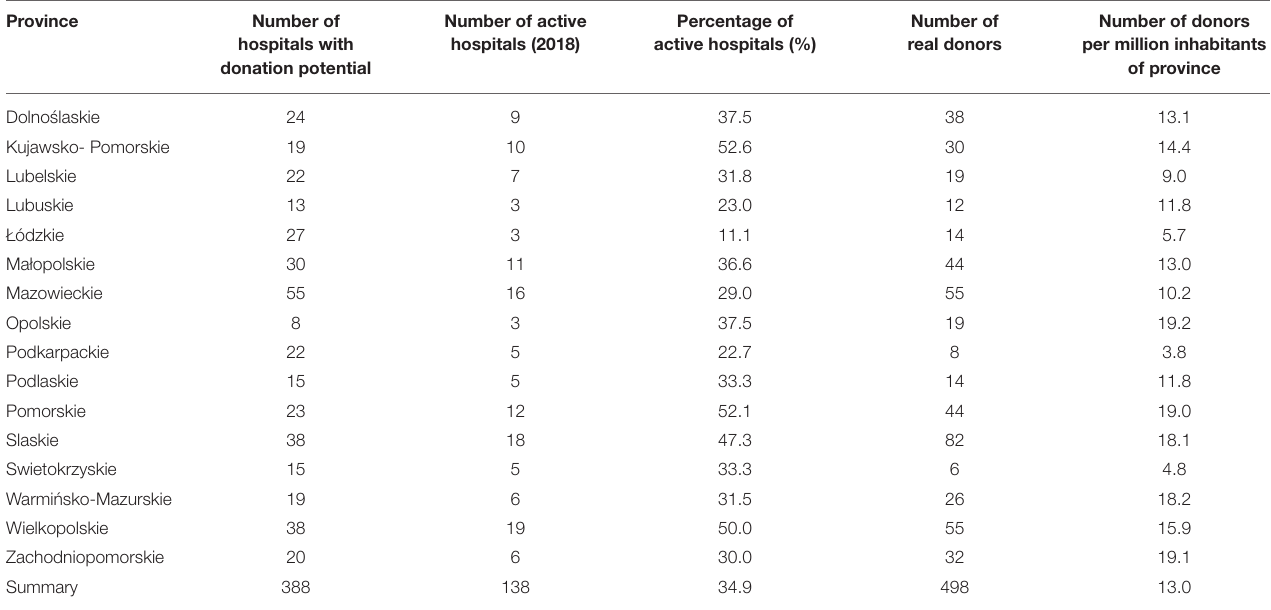
TABLE 1 | Collation of hospitals with donation potential, active hospitals, the number of real organ retrievals and donors per million inhabitants in every province in 2018 (2).